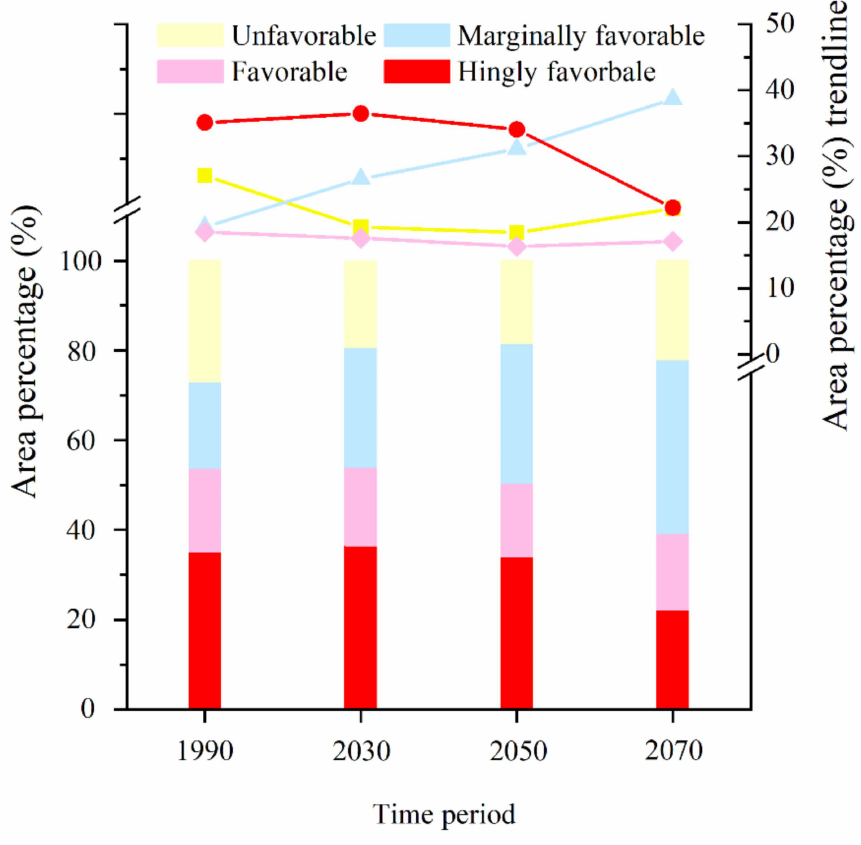
Figure 4. The percentages of various habitats during different periods and their trendlines in the total distribution area of P. interpunctella in